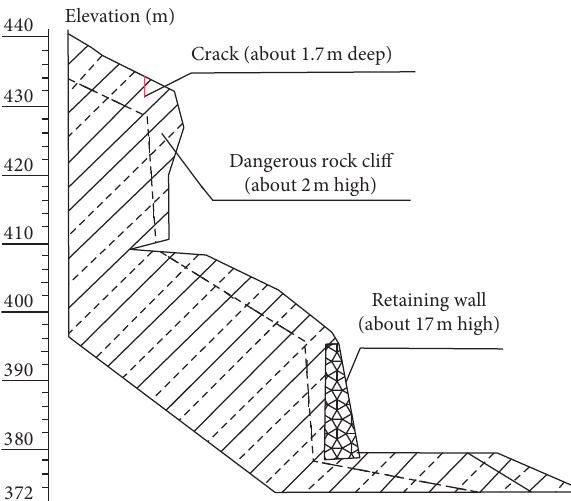
Figure 8: Falling-type dangerous rock mass of W 3.